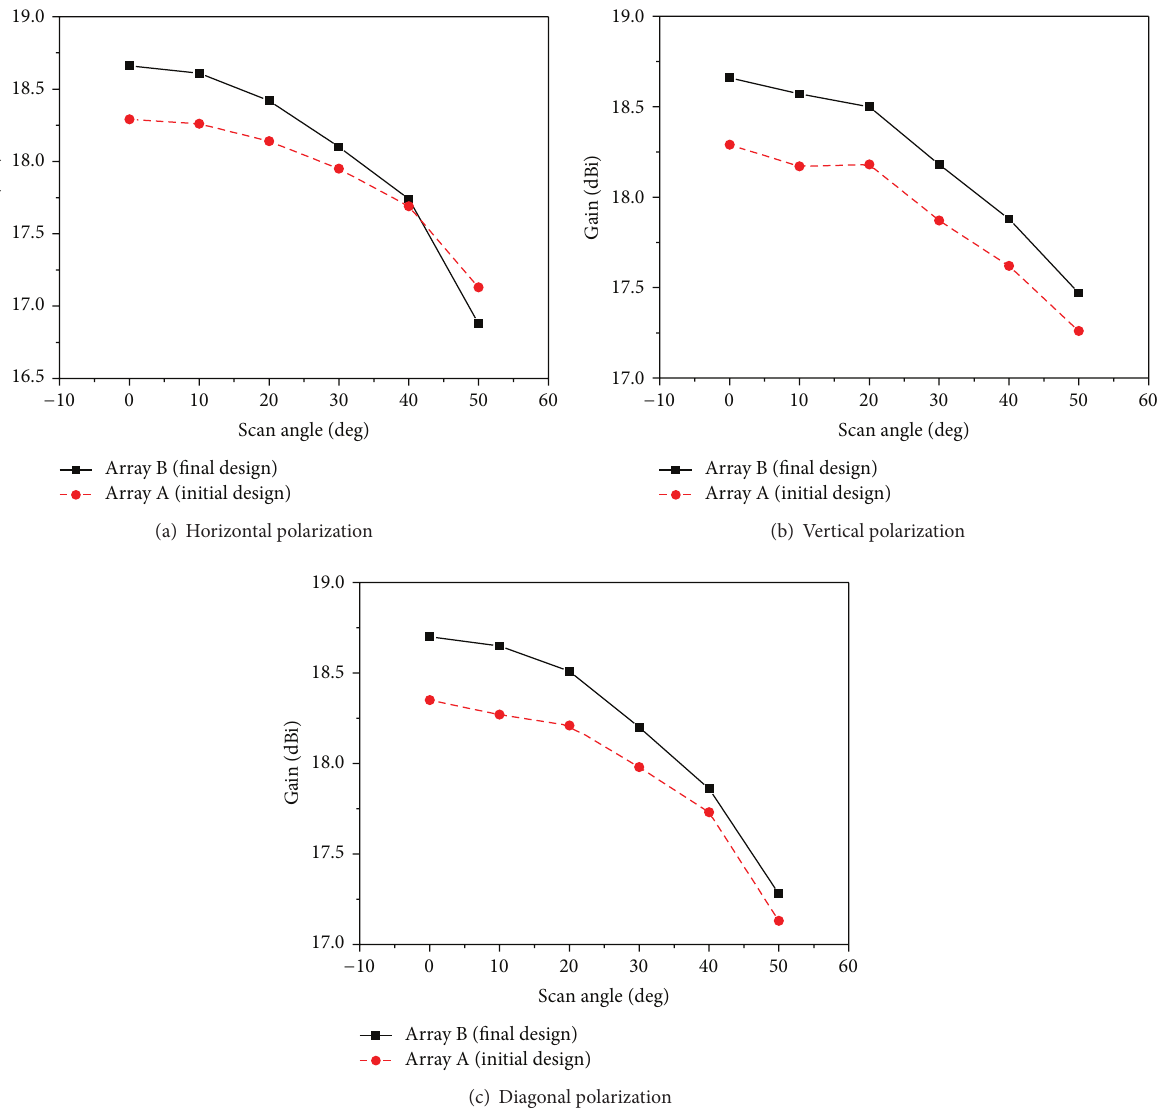
Figure 7: The comparison of gain during polarization tracking and beam scanning (azimuth angle 𝜑 = 0 ∘ ).